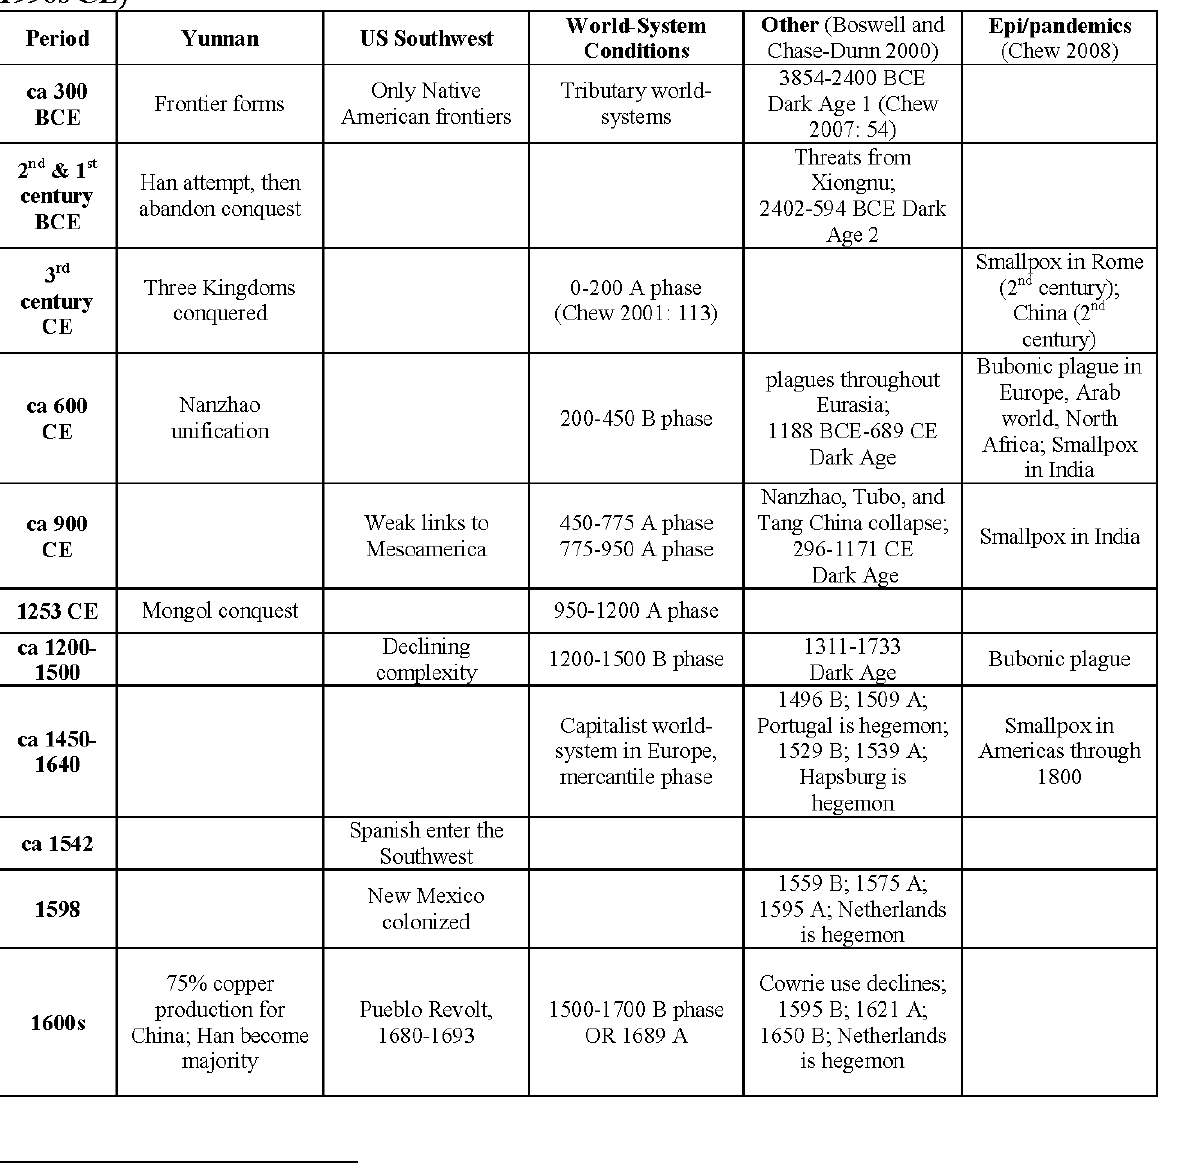
Table 1: Timelines for Greater Yunnan, Greater Southwest, and World-System (300 BCE